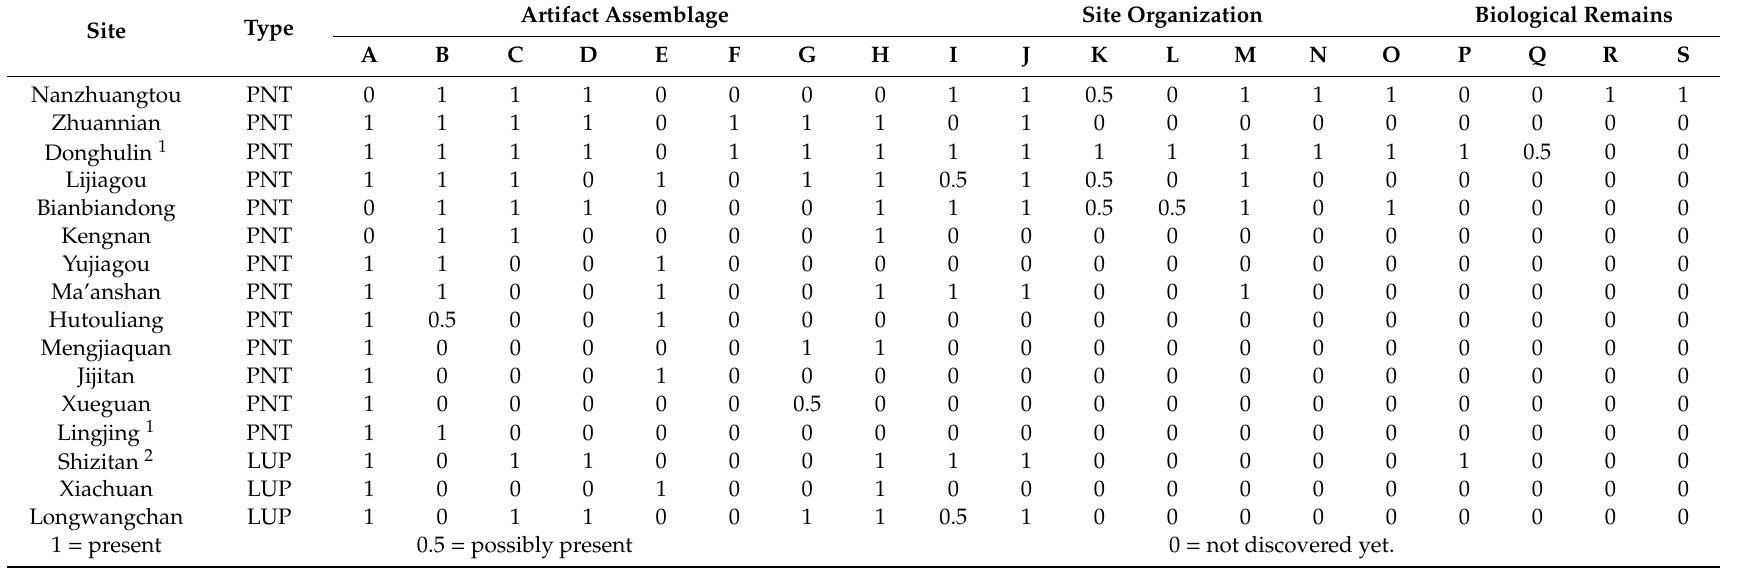
Table 3. Presence of markers of the PNT in North China, by site 3 Table 2 modified from [2]. These sites are mapped in Figure